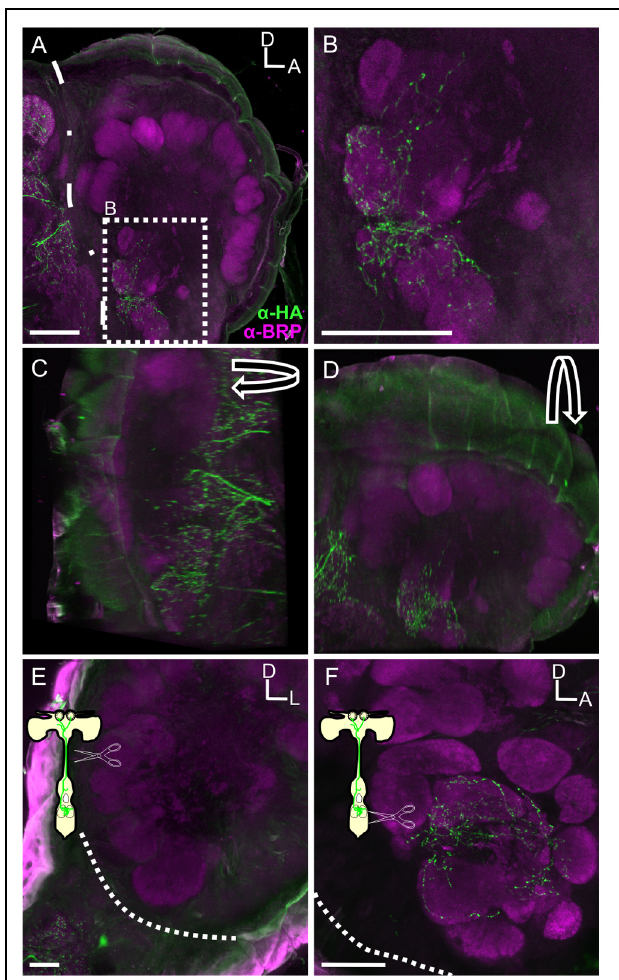
FIGURE 4 | The MDH neurons provide the sole source of HA-ir input to the ALs. (A) Saggital section of the AL with HA-ir (green). BRP (magenta) outlines glomeruli of the AL. Dotted line outlines the posterior boundary of the AL. Scale bar = 100 μ m. (B) High magnification view of inset from (A) . Highly varicose HA-ir processes innervate 4–6 ventral posterior glomeruli. Scale bar = 50 μ m. (C) Rotation of image (A) about the y -axis showing HA still overlapping with BRP labeling. (D) Rotation of image (A) about the x -axis again showing HA overlapping with BRP labeling, collectively confirming that HA ramifies glomeruli. (E) Frontal section showing that HA-ir is absent in the AL following ablation of the cervicothoracic connective. Scale bar = 100 μ m. (F) Sagittal view of HA-ir in the AL following ablation between the MsG and the metathoracic ganglia in which the lesioning of metathoric HA-ir neuron axons was confirmed. Dashed lines indicate boundary of AL in (E,F) . Scale bars = 50 μ